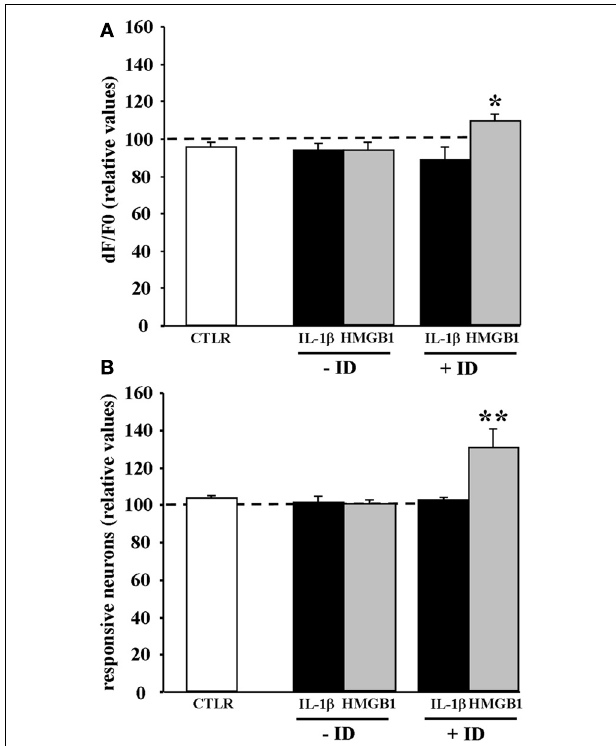
FIGURE 5 | HMGB1 can act directly onto NMDA receptors after the brain tissue experienced epileptiform activities. Mean peak amplitude of the neuronal Ca 2 + change (A) and mean number of responsive neurons (B) evoked by a single NMDA pulse applied in 0.5mM Mg 2 + and TTX. Slices were treated with IL1 β or HMGB1 and experienced ( + ID) or did not experience ( − ID) an ictal-like discharge before TTX application. IL1 β (black bars; 12 slices, 465 neurons, 9 animals), HMGB1 (gray bars; 13 slices, 575 neurons, 9 animals). The white bars correspond to data from control slices with saline applications instead of the cytokine applications (6 slices, 290 neurons, 3 animals). In each experiment (cid:2) F/F0 max values and number of NMDA responsive neurons after cytokine treatment are normalized with respect to internal control. Neurons from the HMGB1 treated slices that experienced previous epileptic activity increase significantly their response to NMDA (7 slices, 5 animals). ∗ p = 0 . 05, ∗∗ p = 0 . 01, Mann-Whitney